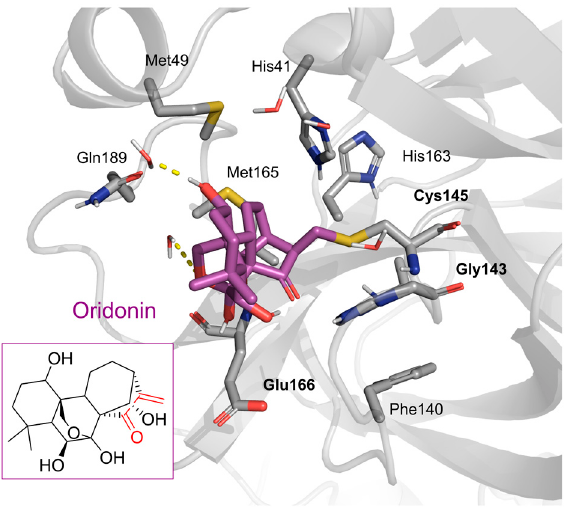
Figure 1. Oridonin-binding mode in the M pro binding site, determined by crystallography (PDB ID: 7VIC). Dashed yellow lines represent polar contacts such as hydrogen bonds and water